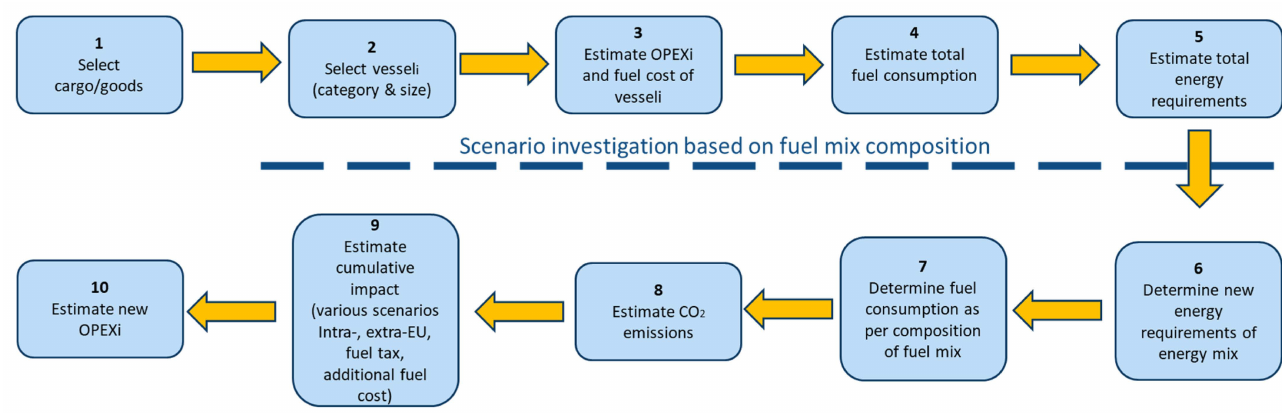
Figure 4. MSF455 assesses new OPEX , cumulative impact, and estimation of effect on the market demand based on various scenarios and projections of products arriving at EU ports.